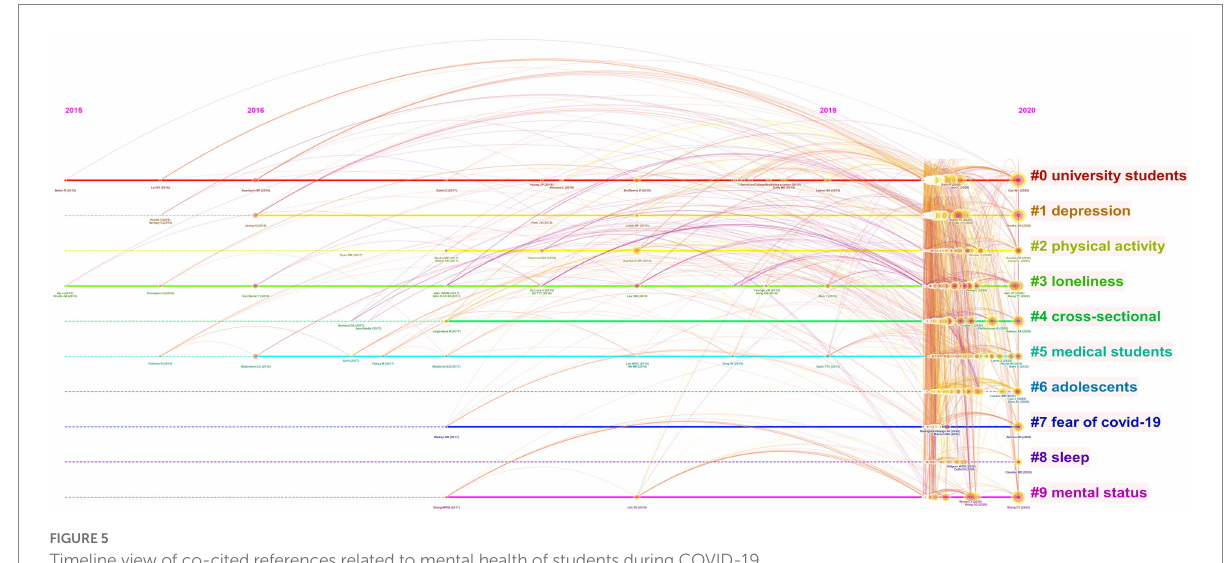
FIGURE 5 Timeline view of co-cited references related to mental health of students during COVID-19.